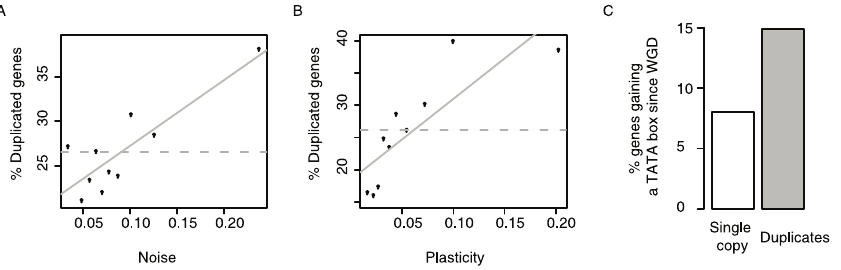
Figure 4. Gene duplicates are enriched amongst genes with the highest expression noise and plasticity, and they tend to gain TATA promoters. The proportion of duplicates is shown for genes with different expression noise (A) and plasticity (B). Proportions shown for equally populated bins of genes. (C) Genes retained as duplicates following the whole genome duplication in yeast are more likely to have gained a TATA box in their promoters since the duplication event than those reverting to a single copy (P=1.24 6 10 2 5 , Fischer’s exact test). Here, only genes inferred to have ancestral TATA-less promoters are considered, N=470 (retained as duplicates) and N=1994 (not retained as duplicates).